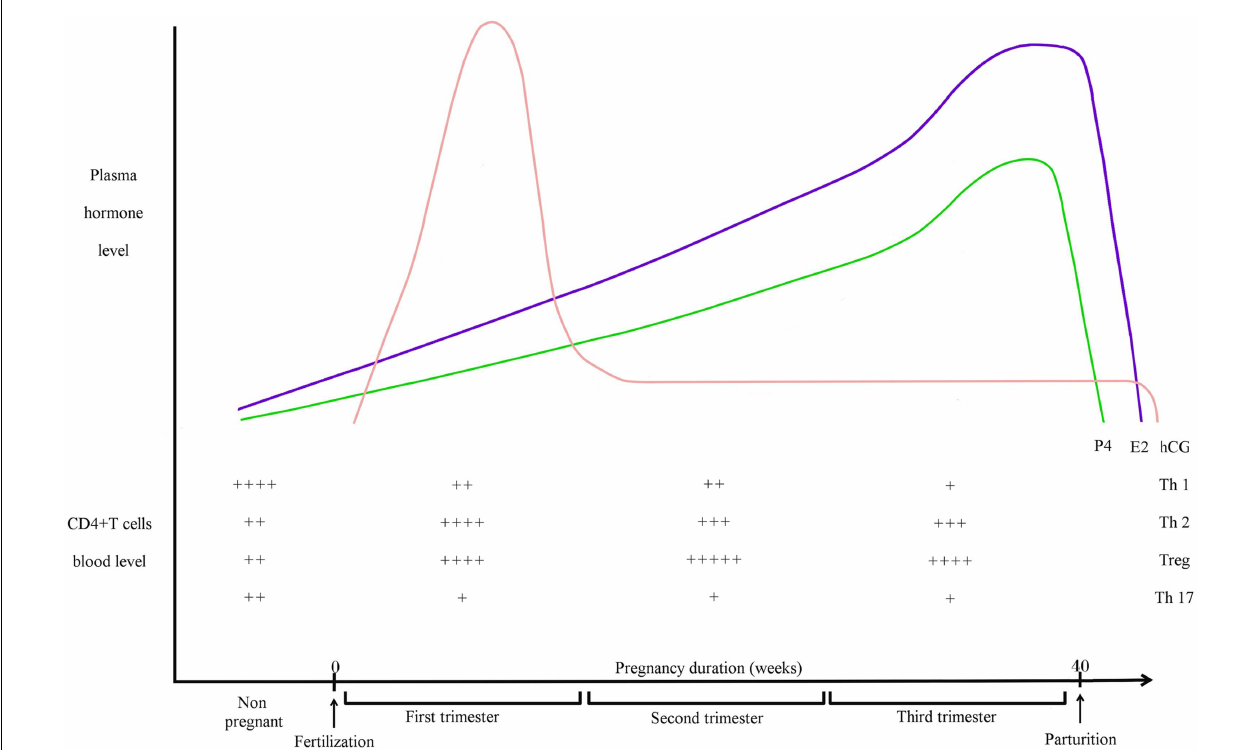
FIGURE 1 | Pregnancy hormones and CD4 + T cells blood levels during human pregnancy . hCG is an embryonic signal that announces the presence of an embryo to the maternal organism. hCG gene is transcribed as early as the eight-cells stage but it cannot be detected in the maternal blood before the second week after fertilization. Blood hCG concentration reaches a peak between the 8th and 11th week then it declines and stays low until the end of pregnancy. E2 is mainly produced by ovarian granulosa cells and by placenta. E2 concentration in maternal blood increases gradually after the first week, reaches a peak before parturition then drops few days after. Secreted mainly by corpus luteum then by placenta after 12weeks of pregnancy, small